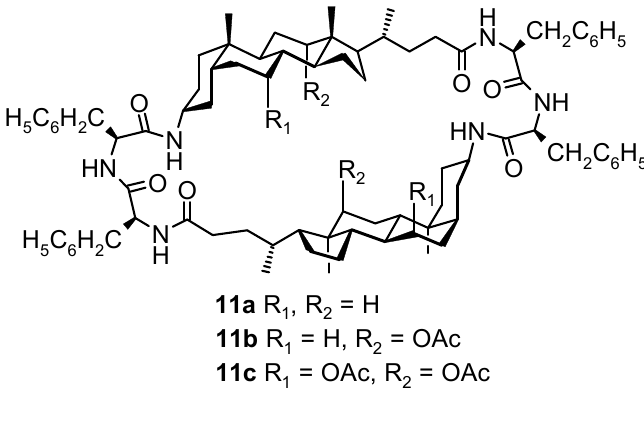
Figure 5. Steroidal cyclopeptides